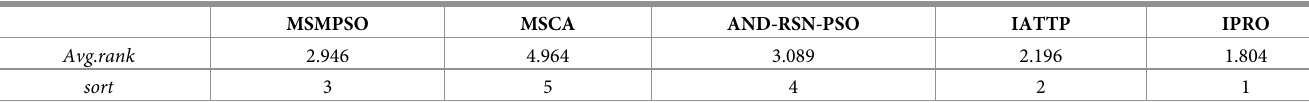
Table 9. Friedman- test of 5 algorithms (D =